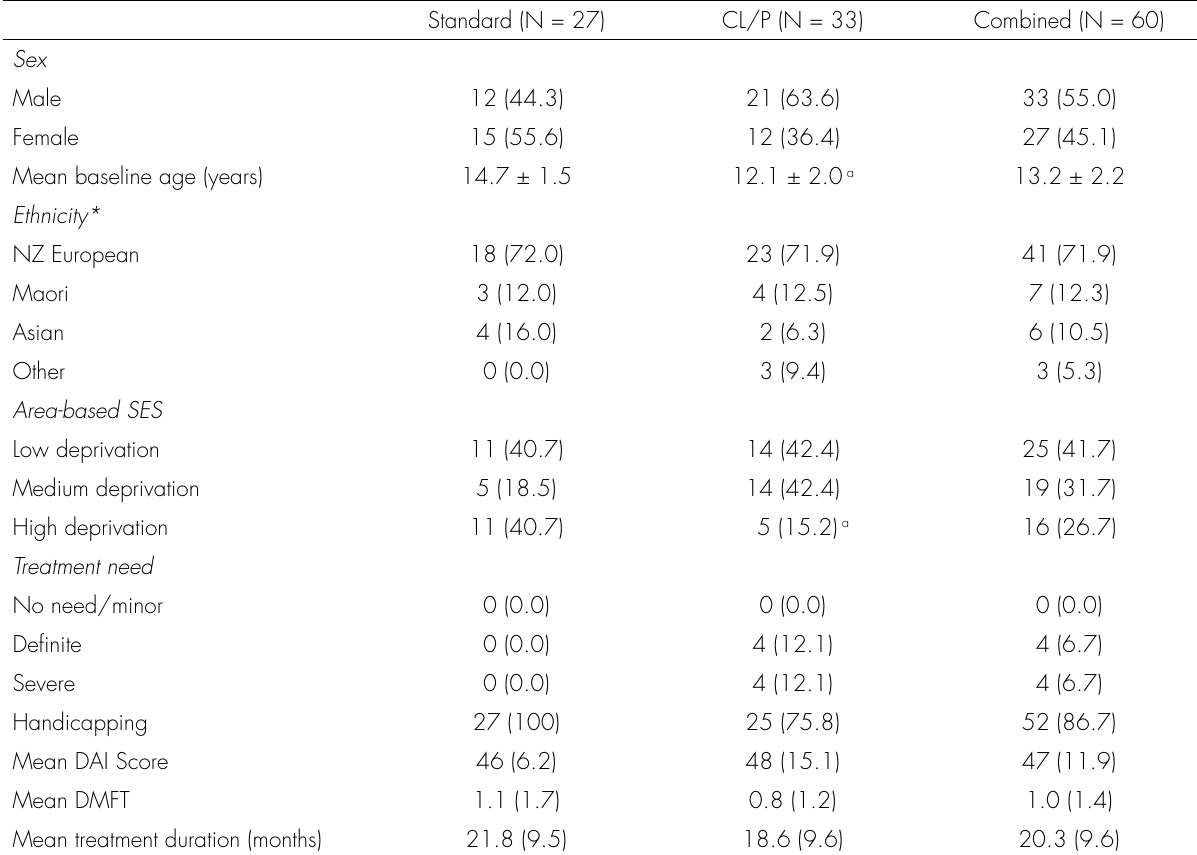
Table I. Sociodemographic characteristics by study group (brackets contain percentages unless otherwise stated).